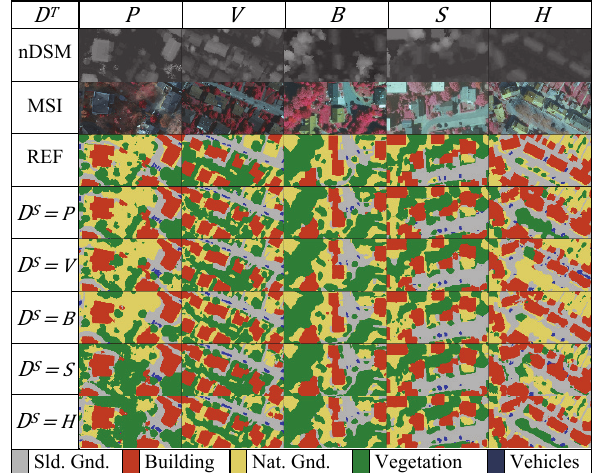
Figure 2: Exemplary test set samples and predictions. First three rows show nDSM, MSI and reference for a 256⨯500 region of each domain. Remaining rows show predictions after adaptation where D S (cid:3405) D T and before adaptation where D S (cid:3404) D T .